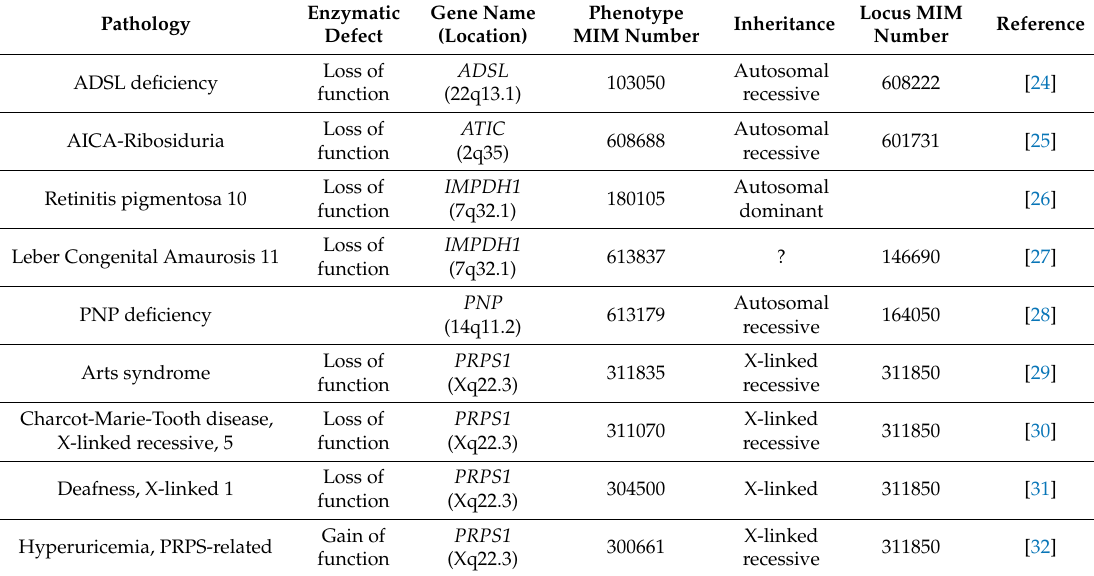
Table 1. Pathologies associated with defects in purine synthesis enzymes highly conserved between yeast and